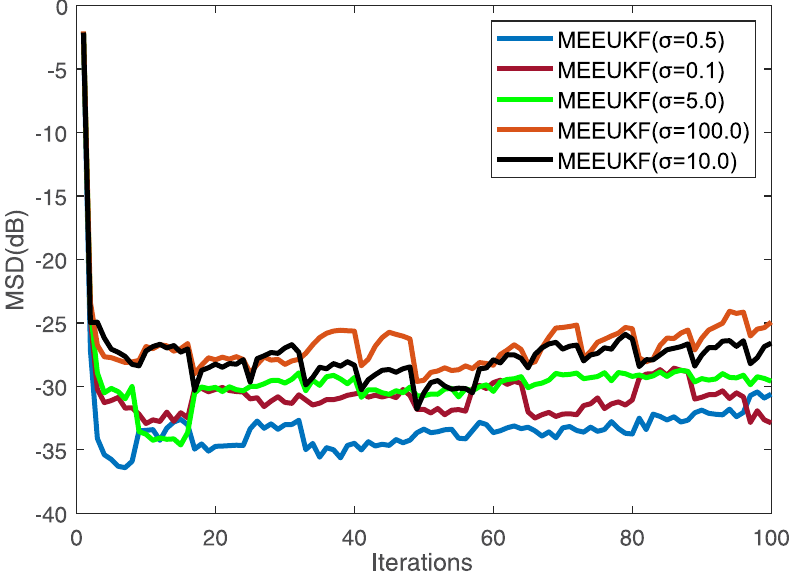
Fig 3. Convergence curves with different kernel bandwidths γ . The picture depicts the convergence curves of the algorithm with different kernel bandwidths.